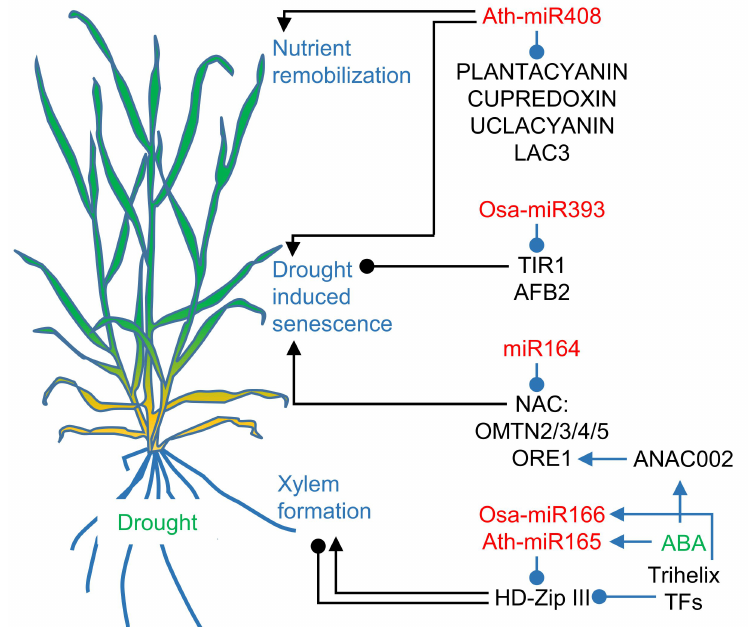
Figure 4. MicroRNAs regulate drought-induced senescence. The panel shows drought- and senescence-related circuits involving microRNAs. The induction of microRNA165/166 alters xylem formation by modulation of class III homeodomain leucine zipper (HD-Zip III) abundance in the vasculature. MicroRNA164 downregulates NAM/ATAF1,2/CUC2 (NAC) TFs, which promote drought-induced senescence. Additionally, abscisic acid (ABA) induces ORESARA1 (ORE1), a senescence-associated TF. MicroRNA393 targets TRANSPORT INHIBITOR RESPONSE 1 (TIR1) and AUXIN SIGNALLING F-BOX PROTEIN 2 (AFB2), which lowers auxin signaling and promotes senescence and drought sensitivity. Plant senescence or increased abiotic sensitivity coincides with the overexpression of microRNA408. MicroRNA408 targets copper-binding proteins. The microRNAs are listed in red, proteins in black, regulated traits in blue, and environmental stress in green. The arrows with triangular points reflect activation, and the arrows with circular tips reflect inhibition. The blue arrows are for regulatory circuits, and the black arrows connect circuits to regulated